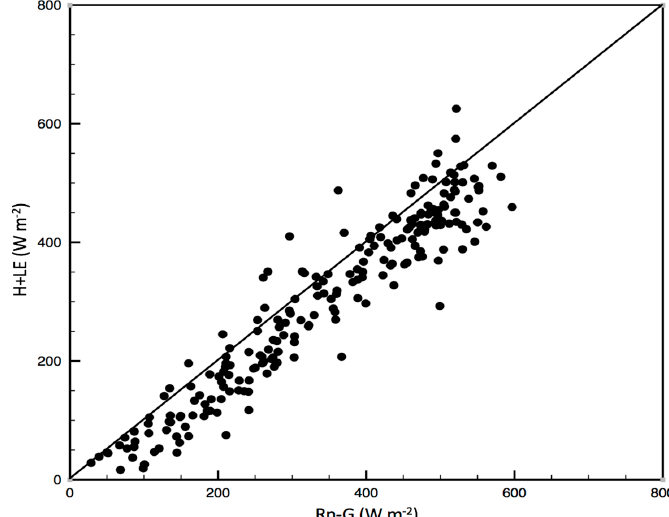
Figure 2. Energy balance closure at interval of 30 min for the days when the satellite overpassed the experimental site. H, LE, Rn, and G correspond to sensible heat flux (W m − 2 ), latent heat flux (W m − 2 ), net radiation (W m − 2 ), and soil heat flux (W m − 2 ), respectively. The coefficient of determination (R 2 ) was 0.88 and the ( Rn − G) /( H + LE ) ratio was 0.89.